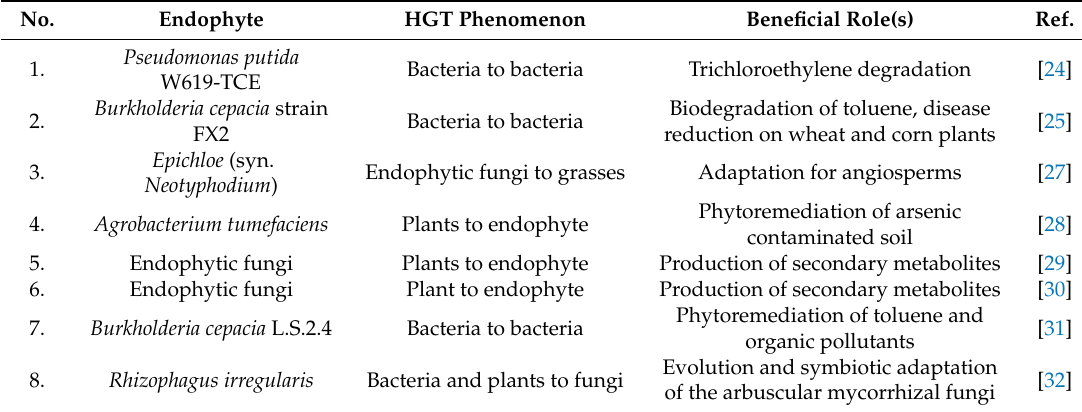
Table 1. A summarized account of the HGT events reported in plant–endophyte